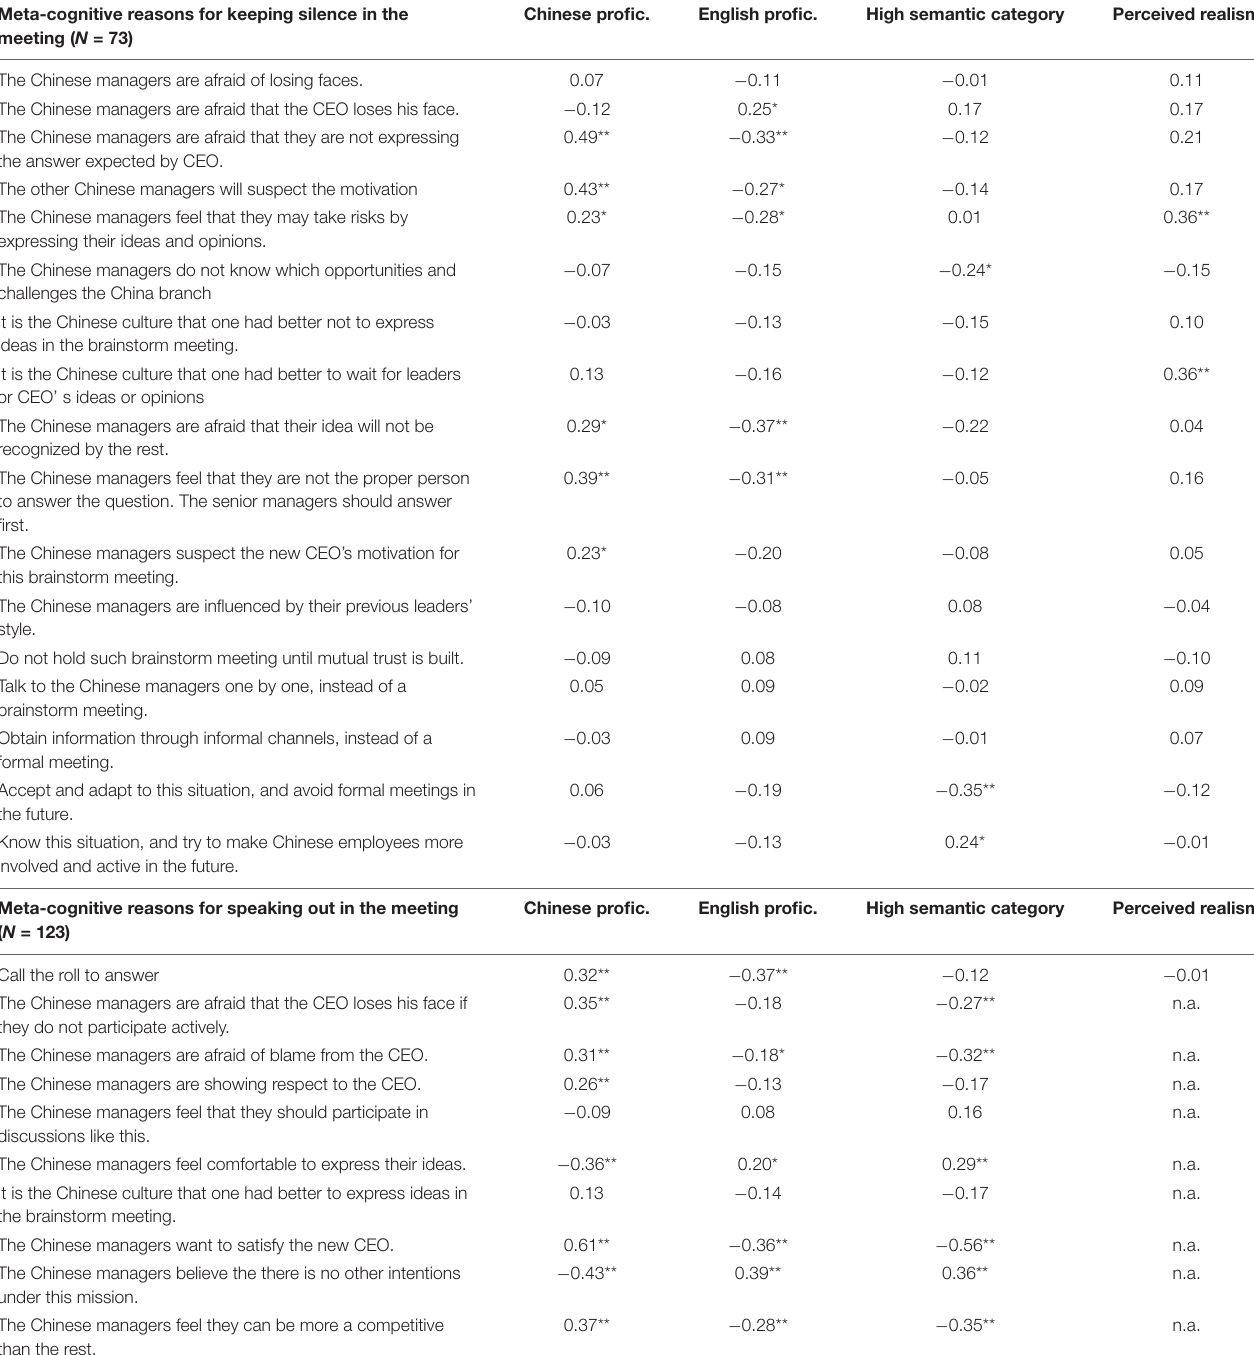
Chinese profic. English profic. High semantic category Perceived